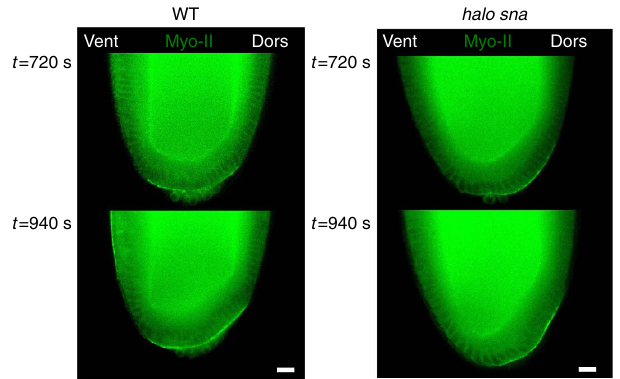
Figure 7 | Distribution of Myo-II-GFP in halo sna at germ-band extension initiation. Representative of the N ¼ 6 WTembryos and the N ¼ 6 halo sna embryos ( P ¼ 2 (cid:3) 10 (cid:2) 3 , exact Fisher test). halo sna invaginate their posterior endoderm (later stages, not shown), as do sna mutants. Scale bars, 5 m